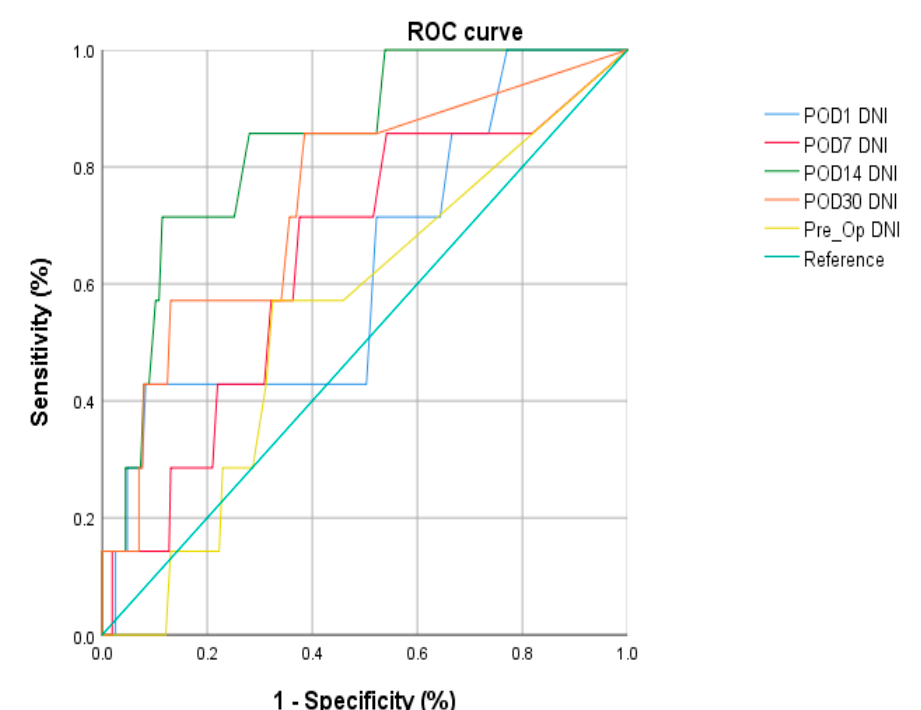
Figure 2. The optimal DNI cut-off level in POD #14 was 2.05 and this cut off level had a sensitivity of 81.8% and a specificity of 82.9%. Table 2. The comparison of 30 days mortality according to the DNI level at POD 14 with a cut-off value of